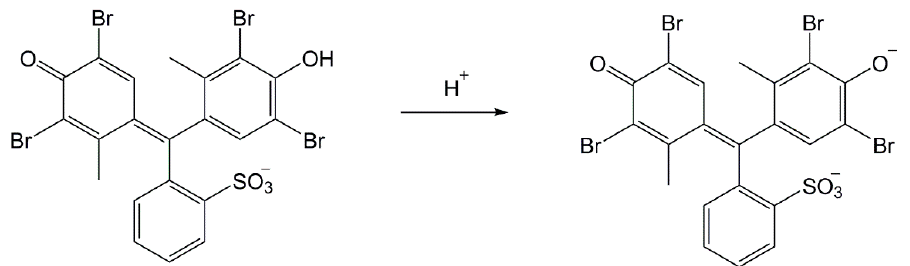
Figure 5. RM1a ( a ) and RM1a/PY-OPD ( b ) detection paper after the exposure to a droplet of CWA.